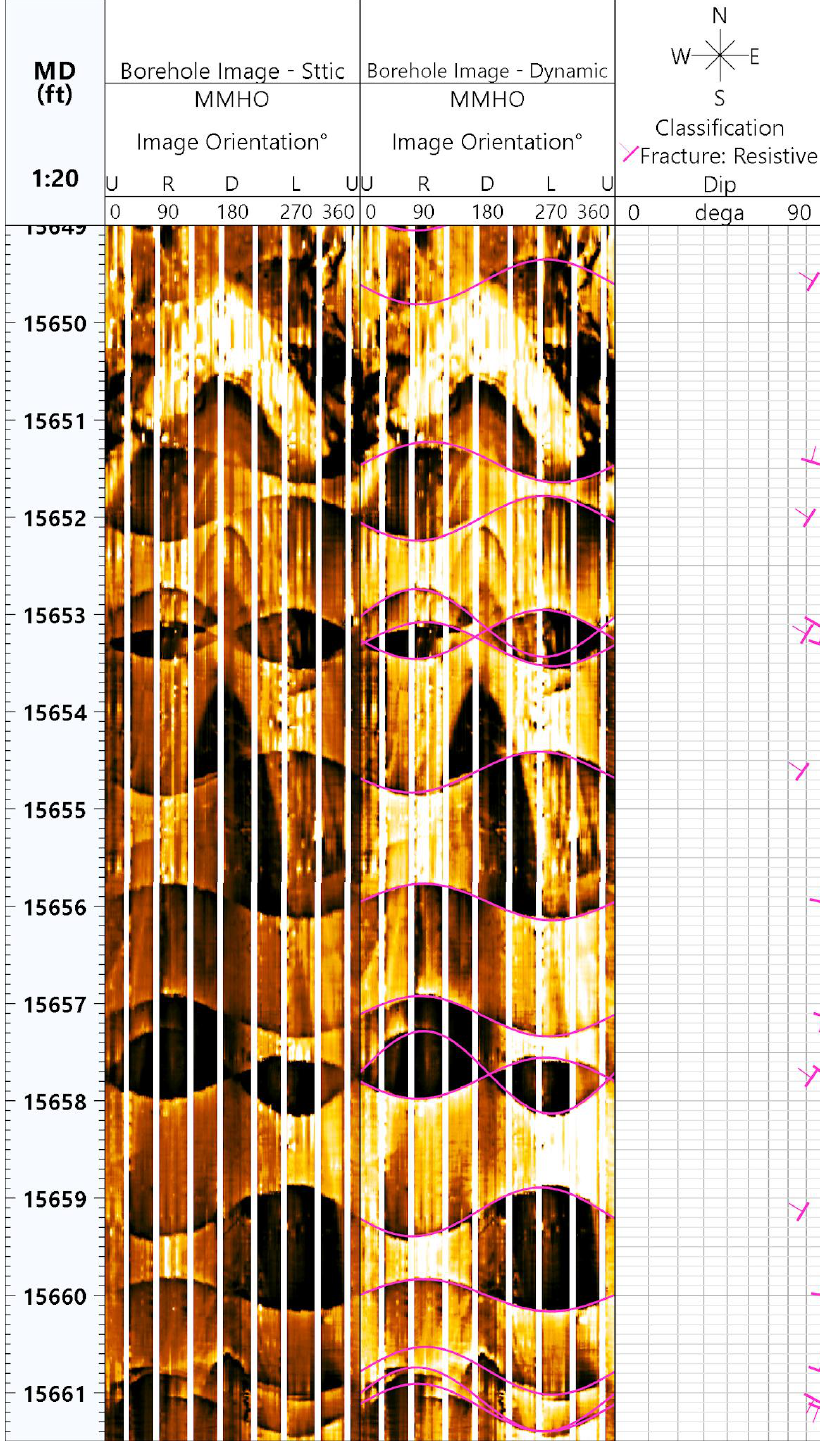
Figure 5. Portion of the static wellbore resistivity image within the Wolfcamp (bottom track) with overlain fracture interpretation (middle track) and fault dip and strike (third track) using fracture dip symbols to display the direction of strike and dip. The dip angle can be determined by the location of the dip symbol in the track (0 – 90°).